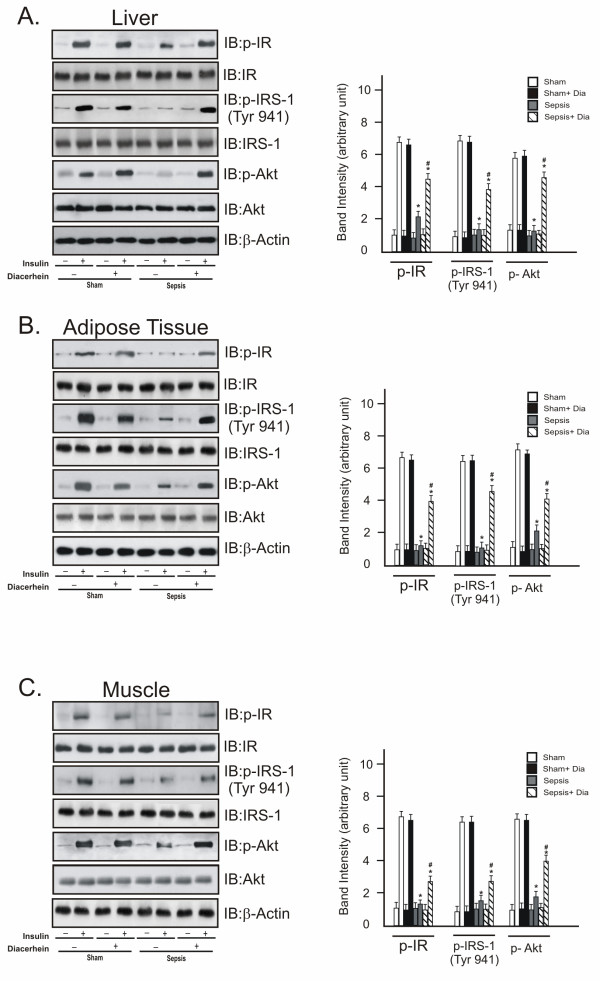
Effects of diacerhein treatment on insulin signaling in the CLP rat. Representative blots show total protein expression and insulin-induced tyrosine phosphorylation of IRβ, IRS1, and serine phosphorylation of Akt in liver (A), adipose tissue (B), and muscle (C) of sham and septic rats. Data are presented as mean ± SEM from six to eight rats per group. *P < 0.05 versus Sham/Vehicle; #P < 0.05 (Sepsis/Veh versus Sepsis/Dia). IB, immunoblot; Sham, Sham/Vehicle; Sham+Dia, Sham/Diacerhein; Sepsis, Sepsis/Vehicle; Sepsis+Dia: Sepsis/Diacerhein.